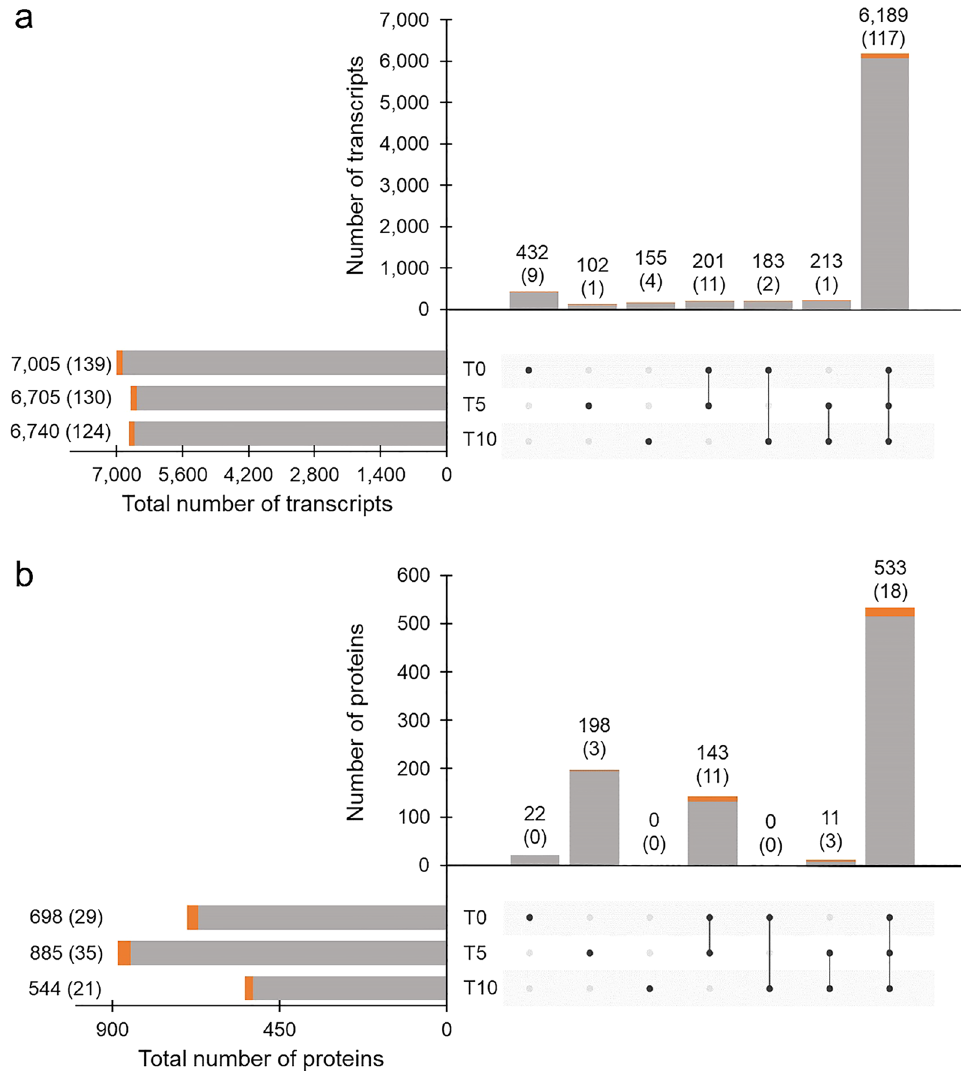
Figure 2. UpSet plots depicting the number of transcripts and proteins quantified in F. hepatica eggs at different points of development. The numbers represent a distribution of protein-coding gene transcripts ( a ) and translated proteins ( b ) at three different points of egg development (T0, T5, and T10). Solitary dots represent transcripts or proteins unique to each time point; two or three dots connected by a line represent the number of transcripts or proteins shared between two or three different time points, respectively. The numbers of quantified peptidases are given in parentheses and highlighted in